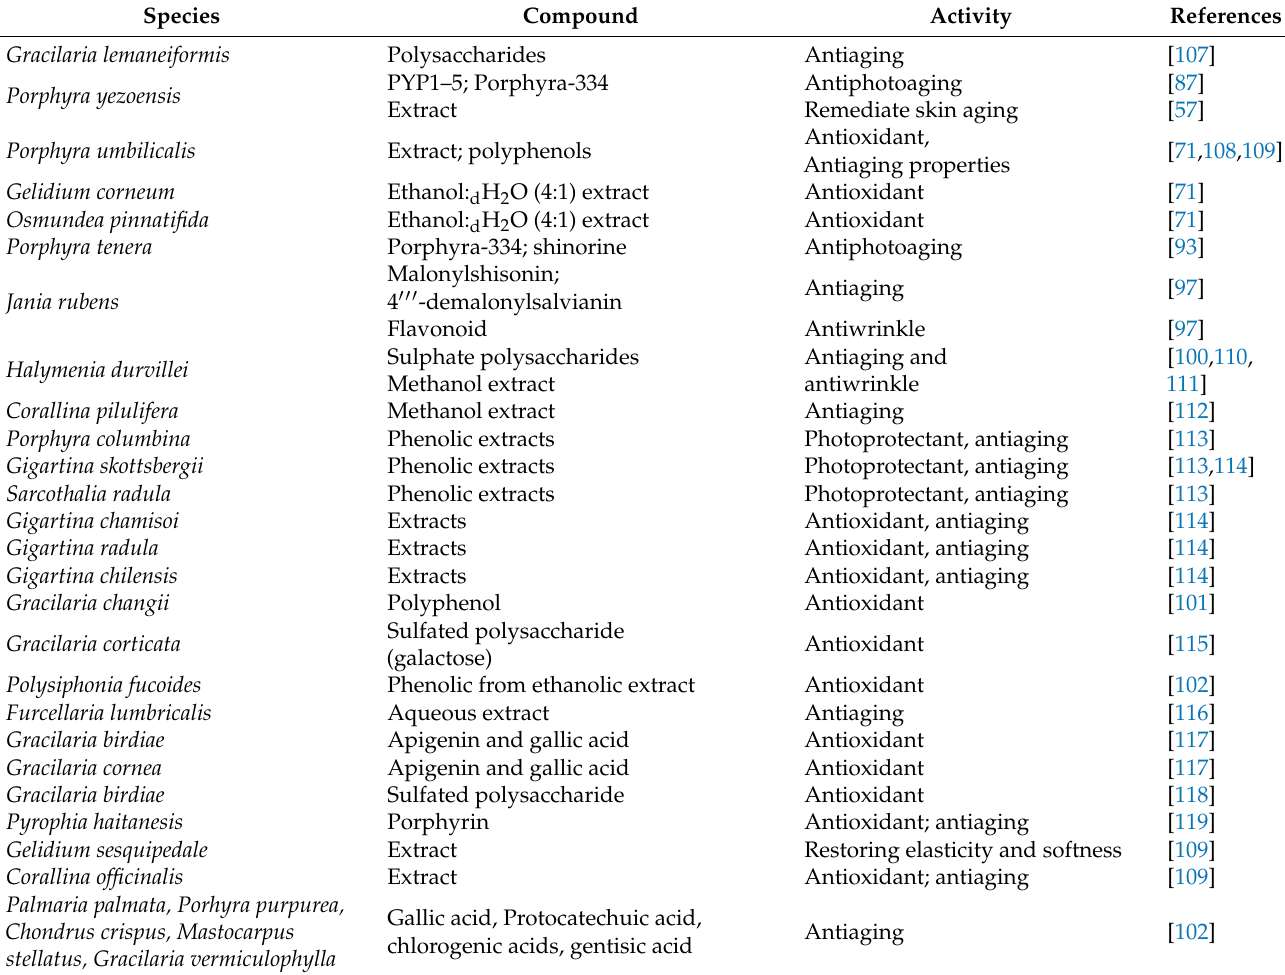
Table 3. Antiphotoaging agents of various red